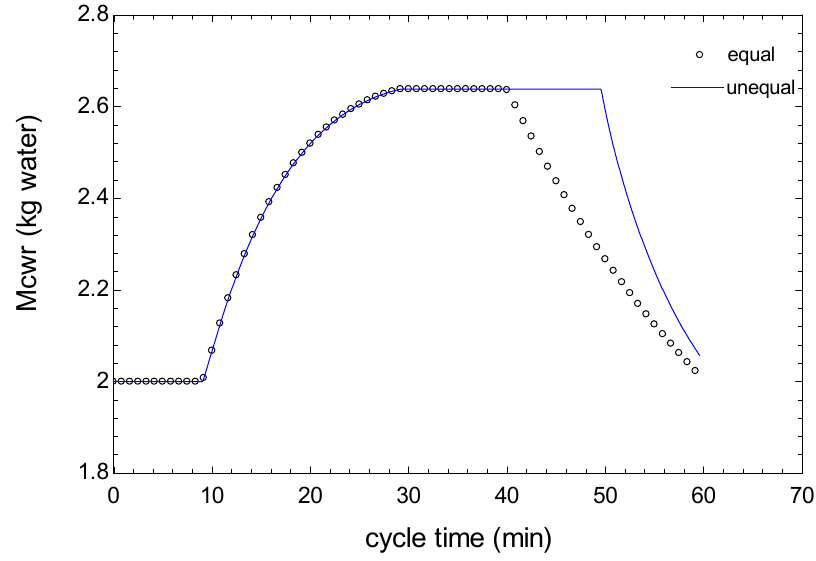
Figure 7. Condensate water profile in the condenser.